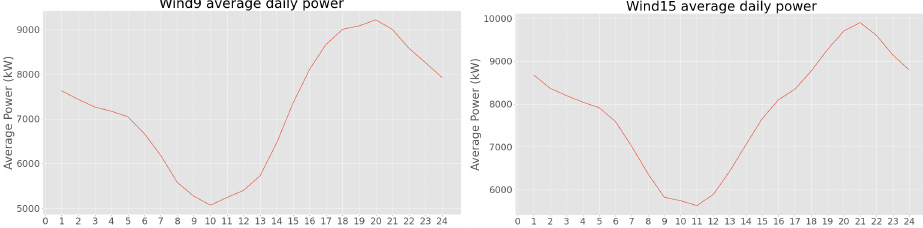
Figure 7. Average production of wind farm 9 ( left ) and wind farm 15 ( right ).